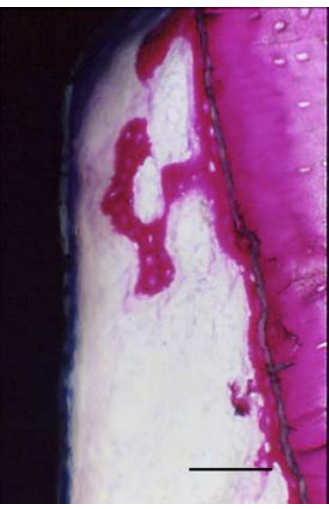
FIGURE 1: LM image of SS screw 2 weeks after surgery. Thin bone trabeculae developing from the host bone run towards the metal surface and cross large loose marrow spaces rich in undifferentiated cells and a wide network of blood vessels. Bar = 100 µm.